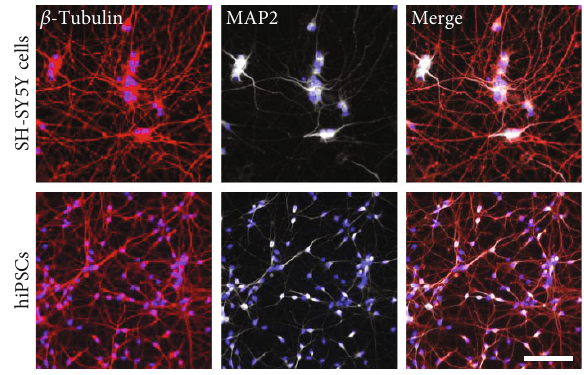
Figure 2: SH-SY5Y- and hiPSC-neurons after neuronal di ff erentiation. Representative staining for β -tubulin con fi rming the presence of neuronal populations in the cultures. Scale bar, 100 μ